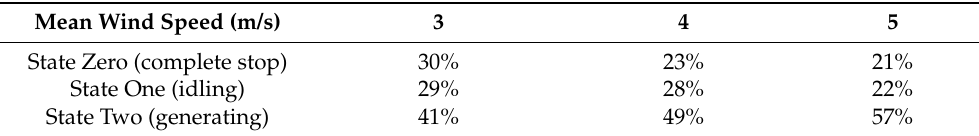
Table 5. Distribution of different wind turbine states for different sites mean wind speeds.